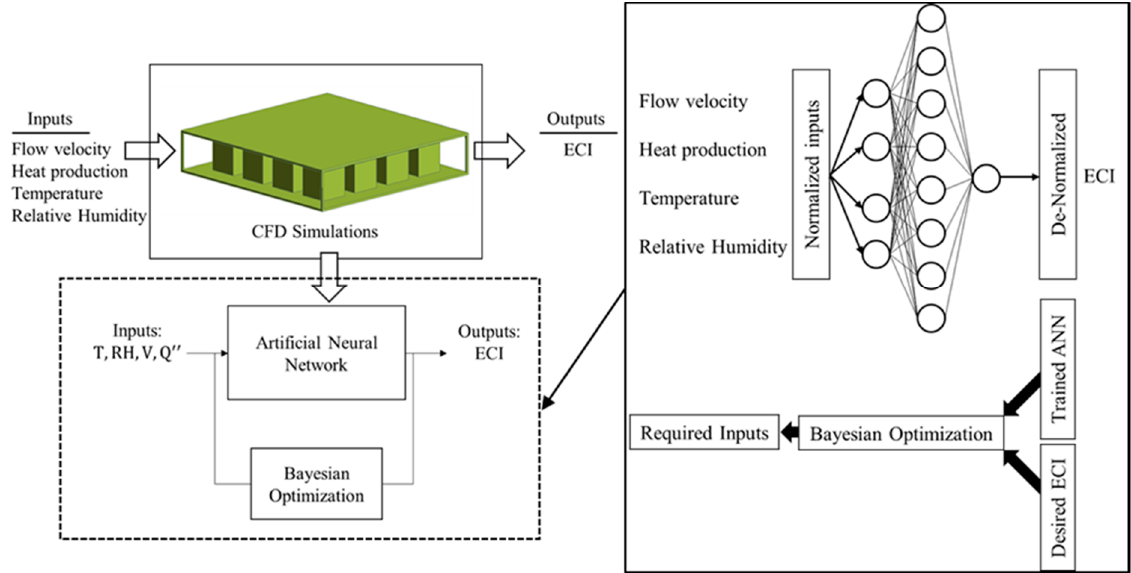
Figure 6. Integration of the CFD model with the machine learning to estimate the range of acceptable input parameters.